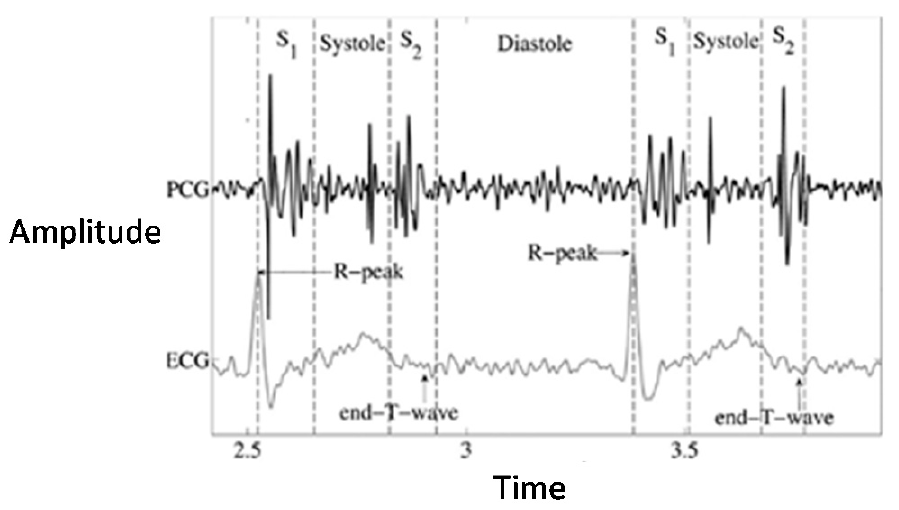
Figure 2. Waveform of PCG.